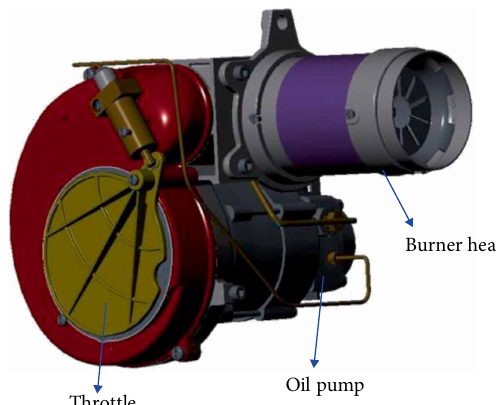
Figure 2: The three-dimensional model diagram of the main components of the Riello 40-G5 oil